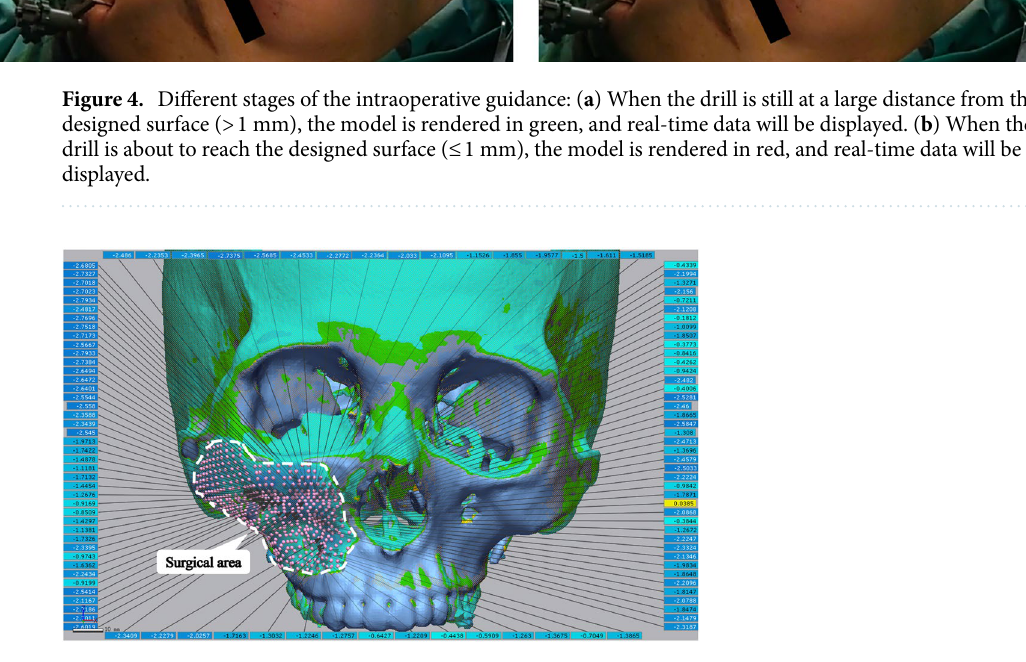
Figure 5. The accuracy evaluation for the performance of the system: The pre-operative virtual plan and post- operative 3D craniomaxillofacial models were imported into 3D analysis software (Geomagic Control X, 3D Systems Inc., South Carolina, USA), and hundreds of pairs of points were generated uniformly in the surgical area. Each of the paired points was located along the normal vector of the skull surface. The distance between the paired points indicated the surgical